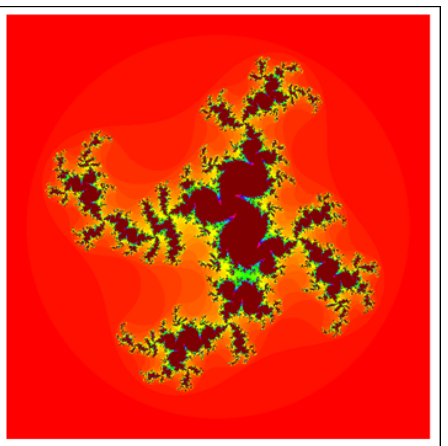
Figure 6. J-set of degree 4 via F-iterative scheme with image visual time = 69.85 s.